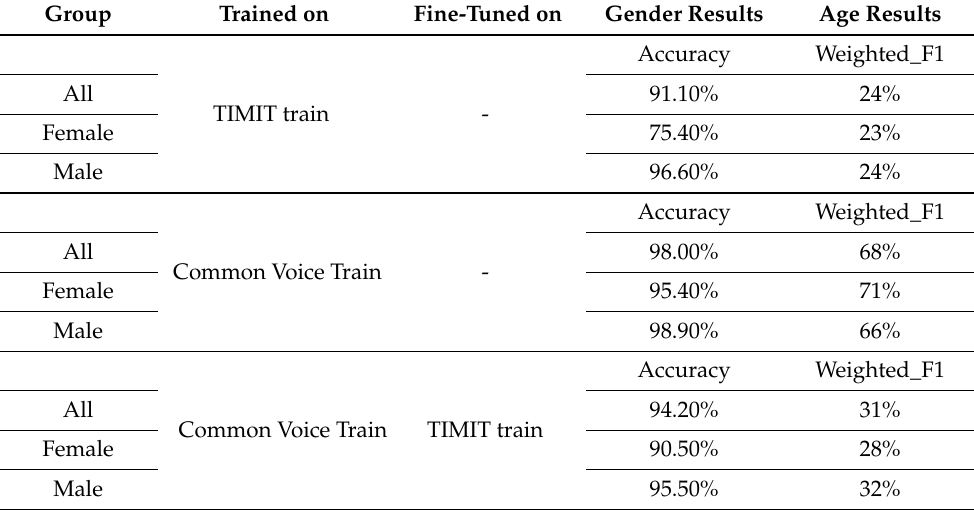
Table 8. Results on the Common Voice test set with a baseline x-vector embedder.